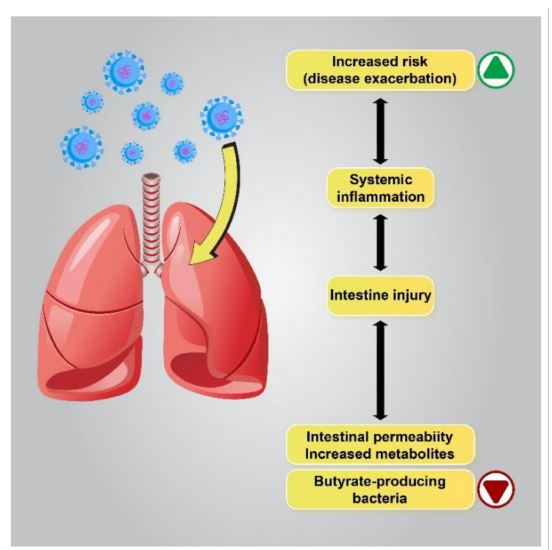
Figure 2. The correlation between flora changes and disease exacerbation. Patients with a lower gut abundance of butyrate-producing bacteria are more likely to develop viral lower respiratory tract infections. Dysbiosis alters metabolite production in the gut by enhancing the permeability of the intestines, which leads to the intensification of pre-existing lung diseases or an increase in the risk of respiratory